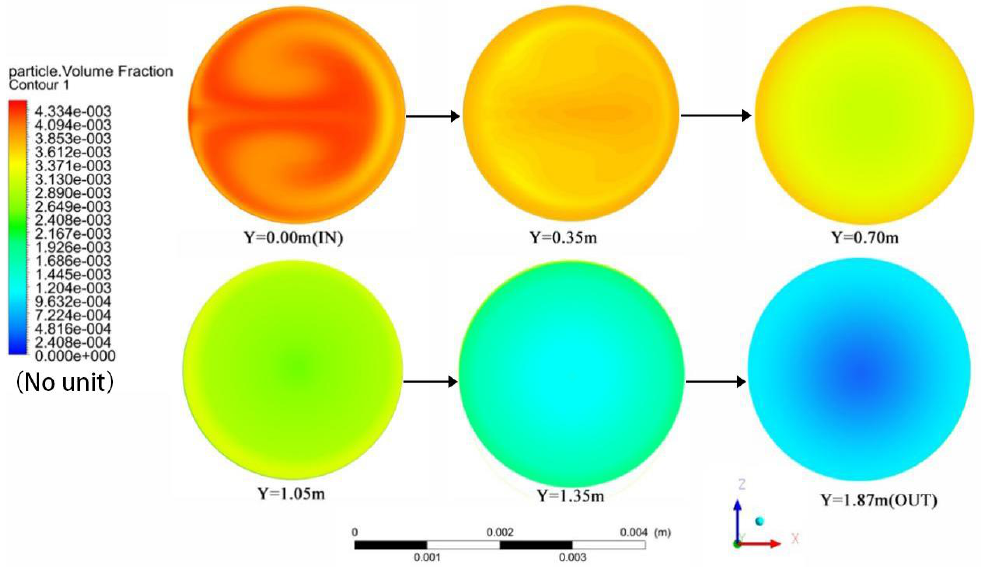
Figure 9. Particle concentration distribution in the heating section.